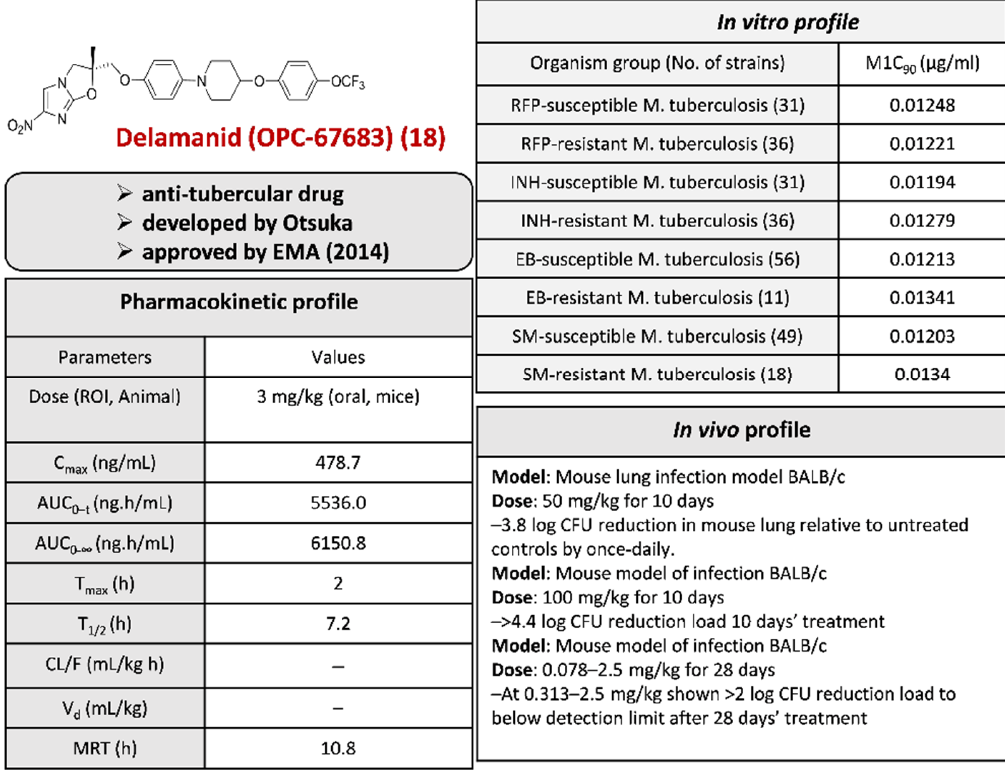
Figure 22. Activity profile of Delamanid 18 [170,171].